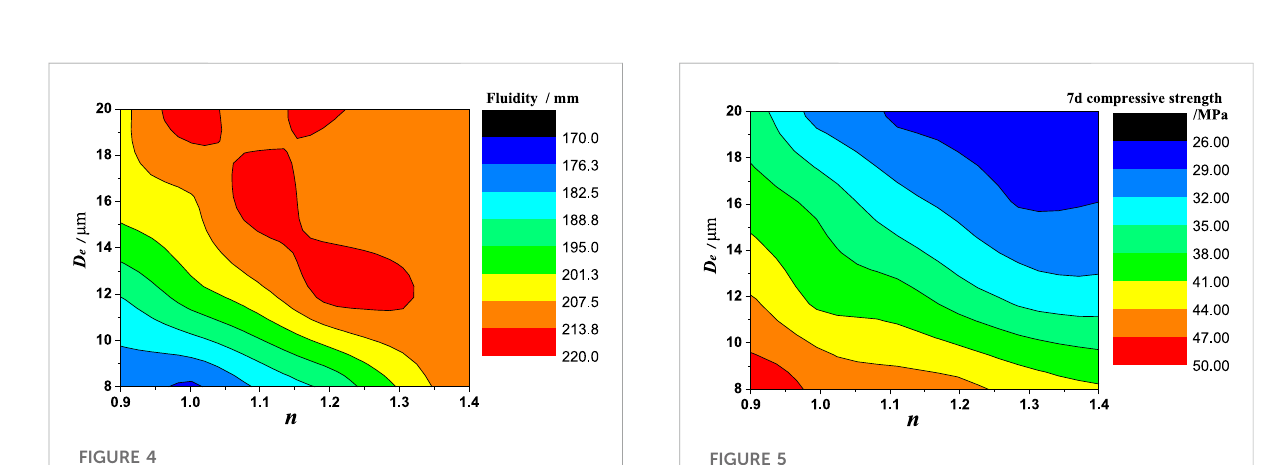
FIGURE 5 The in fl uence of the PSD characteristics on 7-day mortar compressive strength without